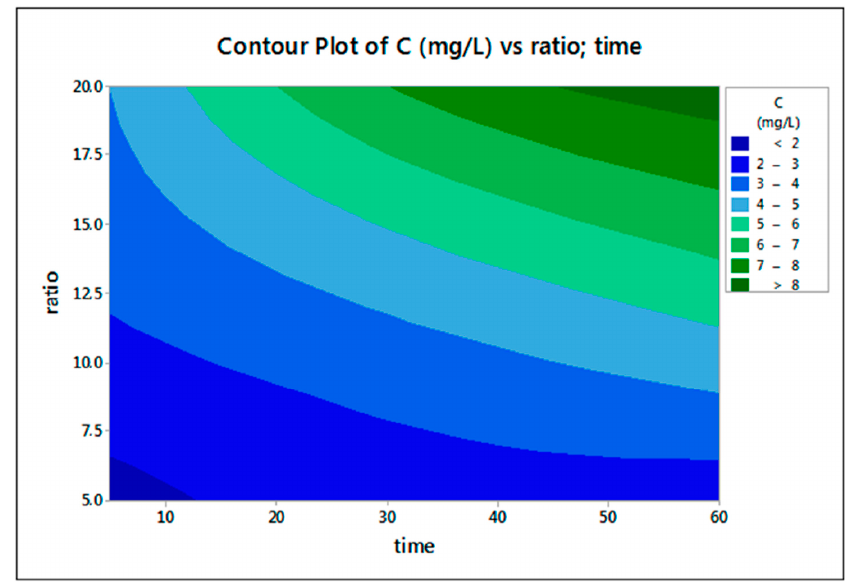
Figure 10. Two-factor (S/L and leaching time) interaction; 2D projection on the extracted Sc concentration in the